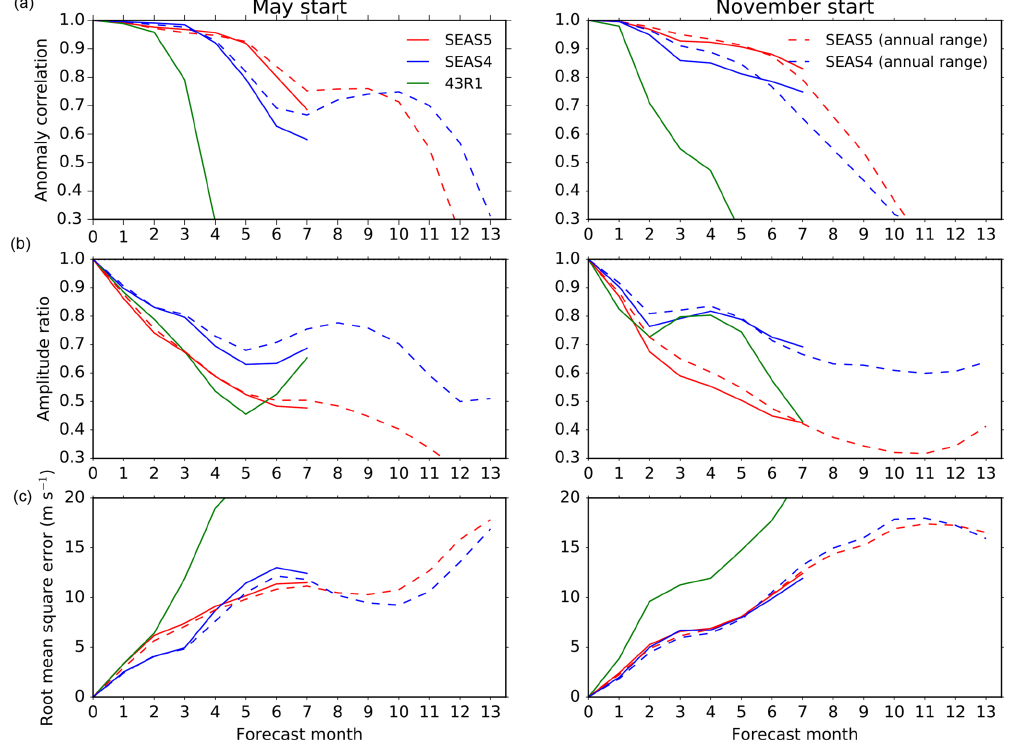
Figure 18. Metrics summarising the phase and amplitude of a QBO index at 30hPa in SEAS4 (blue), SEAS5 (red) and IFS cycle 43r1 with default settings (green) relative to ERA-Interim reanalysis for forecasts initialised in May and November. (a) Anomaly correlation, (b) ratio of the standard deviation of the system to the standard deviation of ERA-Interim reanalysis and (c) RMSE. To compare SEAS4 and SEAS5 fairly with the data available for the default 43r1 cycle, the solid lines use only 5 ensemble members with initialisation dates from 1993 to 2015. The dashed lines compare SEAS4 and SEAS5 for the entire 13 month duration of the annual-range forecasts from 1981 to 2016, using the 15 ensemble